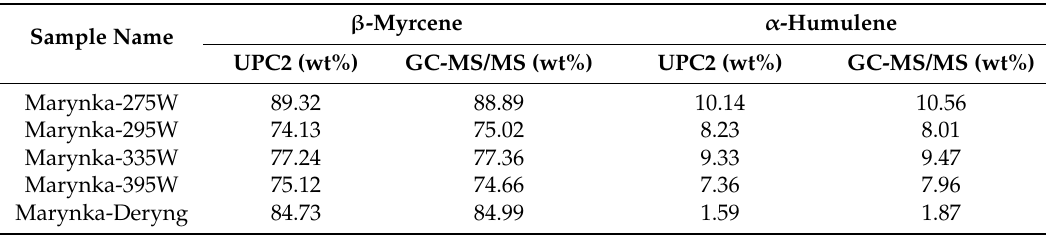
Table 5. The results of quantitative analyses of β -myrcene and α -humulene in essential oils obtained by microwave-assisted hydrodistillation (MAHD) and hydrodistillation